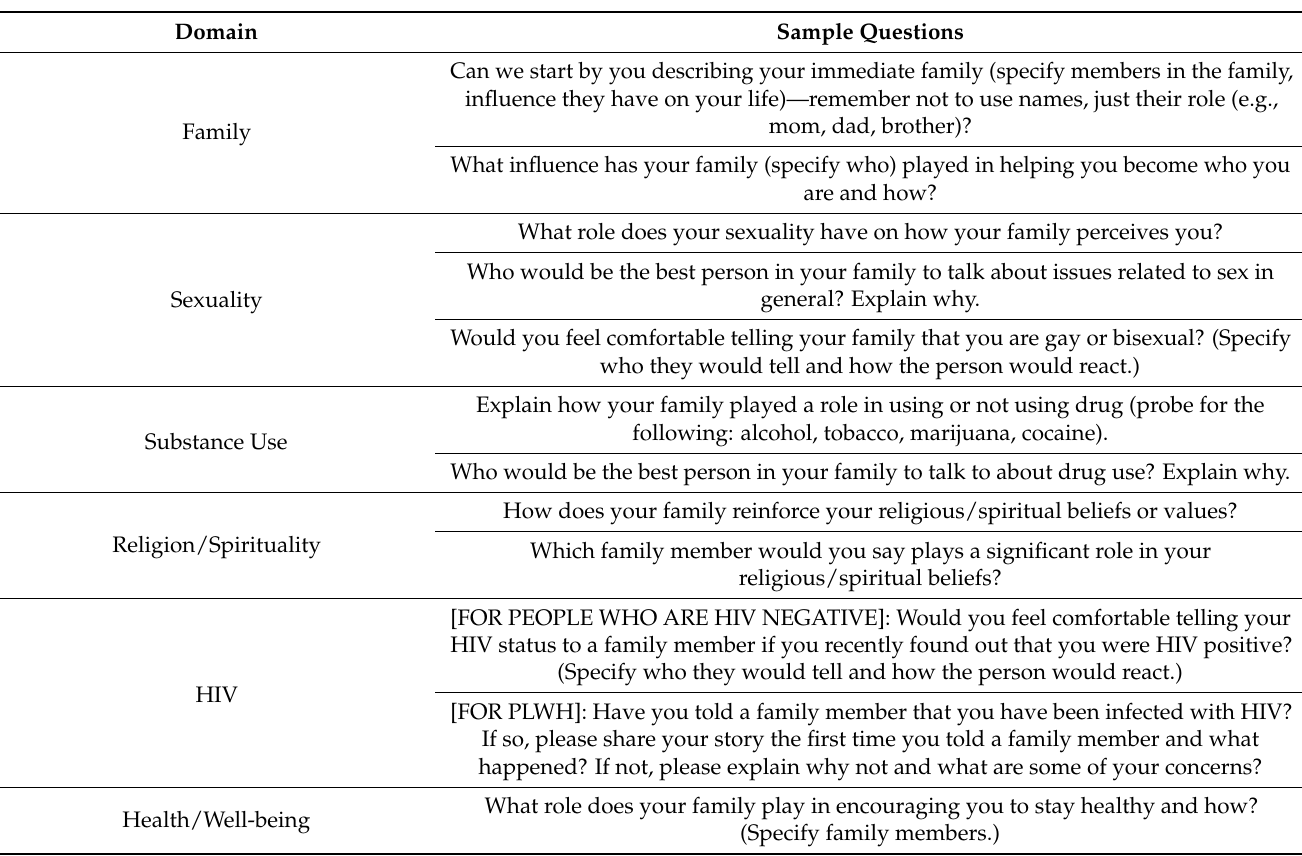
Table 1. Semi-structured interview questions exploring the influence that family had on the well- being of Mexican sexual minority cisgender males ages 21–30 in San Antonio, TX, US. Domain Sample